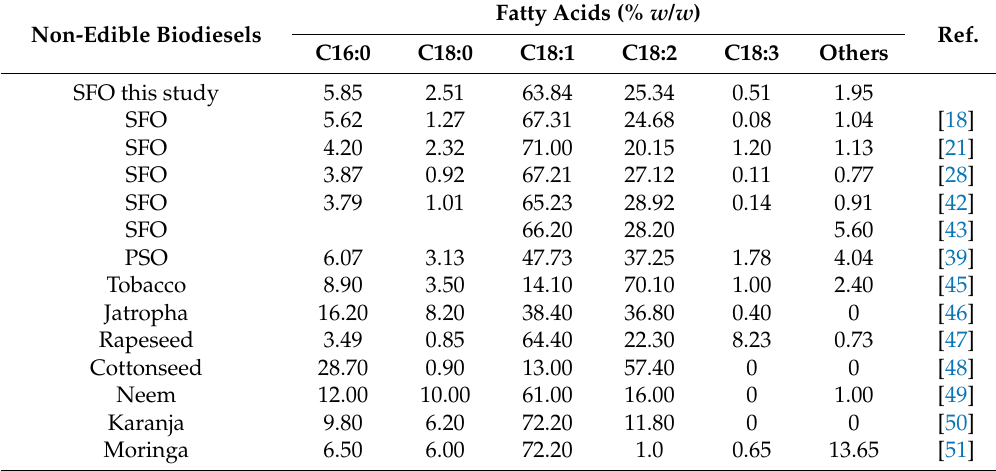
Table 5. Variations in the main fatty acid compositions of selected biodiesel feedstocks. Non-Edible